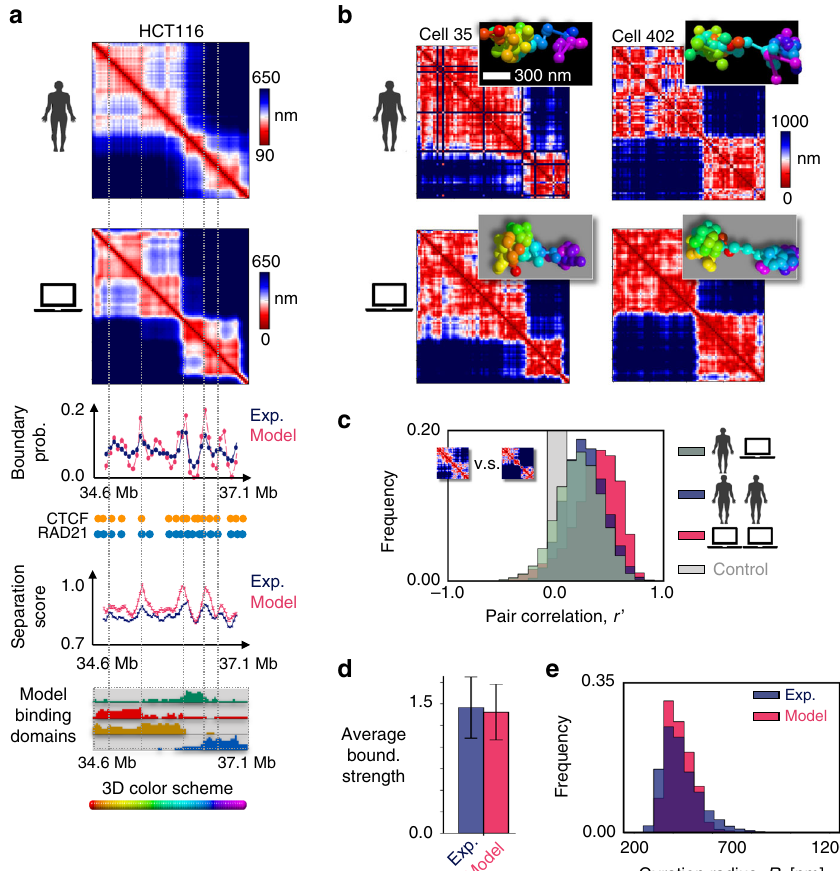
Fig. 2 Phase separation degeneracy explains variability of single-molecule conformations. a In the considered 2.5 Mb wide locus chr21:34.6Mb-37.1 Mb of human HCT116 cells, the model median distance matrix in the globule separated state compares well against imaging data 37 (top, the Pearson and genomic-distance corrected correlations are, respectively, r = 0.95 and r ′ = 0.84). The probability of a domain boundary in 3D conformations along the locus (middle, model-experiment correlation r = 0.79) and the corresponding separation score (model-experiment r = 0.85) also match. The location of ChIP-seq CTCF (orange circles) and cohesin (RAD21, blue circles) sites 58 , and the intensity of the model four types of speci fi c binding sites along the locus (bottom, as in Fig. 1b) are also shown. The vertical dotted lines are drawn to help comparing the panels. b Consistently, an all-against-all comparison of single-cell imaged 37 (top) and model predicted (bottom) 3D structures by the RMSD method shows that all imaged conformations statistically map onto model single molecules in the globule state (bottom, see text and Supplementary Figs. 5b, 6). The varying TAD-like domains result from the intrinsic conformational degeneracy of such a thermodynamic state. c The degree of variability of single-molecules is measured by the genomic-distance corrected correlation, r ′ , of pairs of distance matrices. The distribution of r ′ between pairs of imaged structures (blue, average r ′ = 0.27) is statistically not distinguishable from the r ′ distribution between imaged and model distance matrices (dark gray, two-sided Mann – Whitney p value = 0.19). The model- model r ′ distribution is in red and in light gray a control. d The model and experimental average boundary strength (error bars s.d.), and e the gyration radius distributions are also not distinguishable (two-sided Mann – Whitney p value = 0.40). Overall, the polymer globule phase separated state of the model returns single molecule structures with features consistent with both single-cell imaging and bulk Hi-C (Supplementary Fig. 4a)